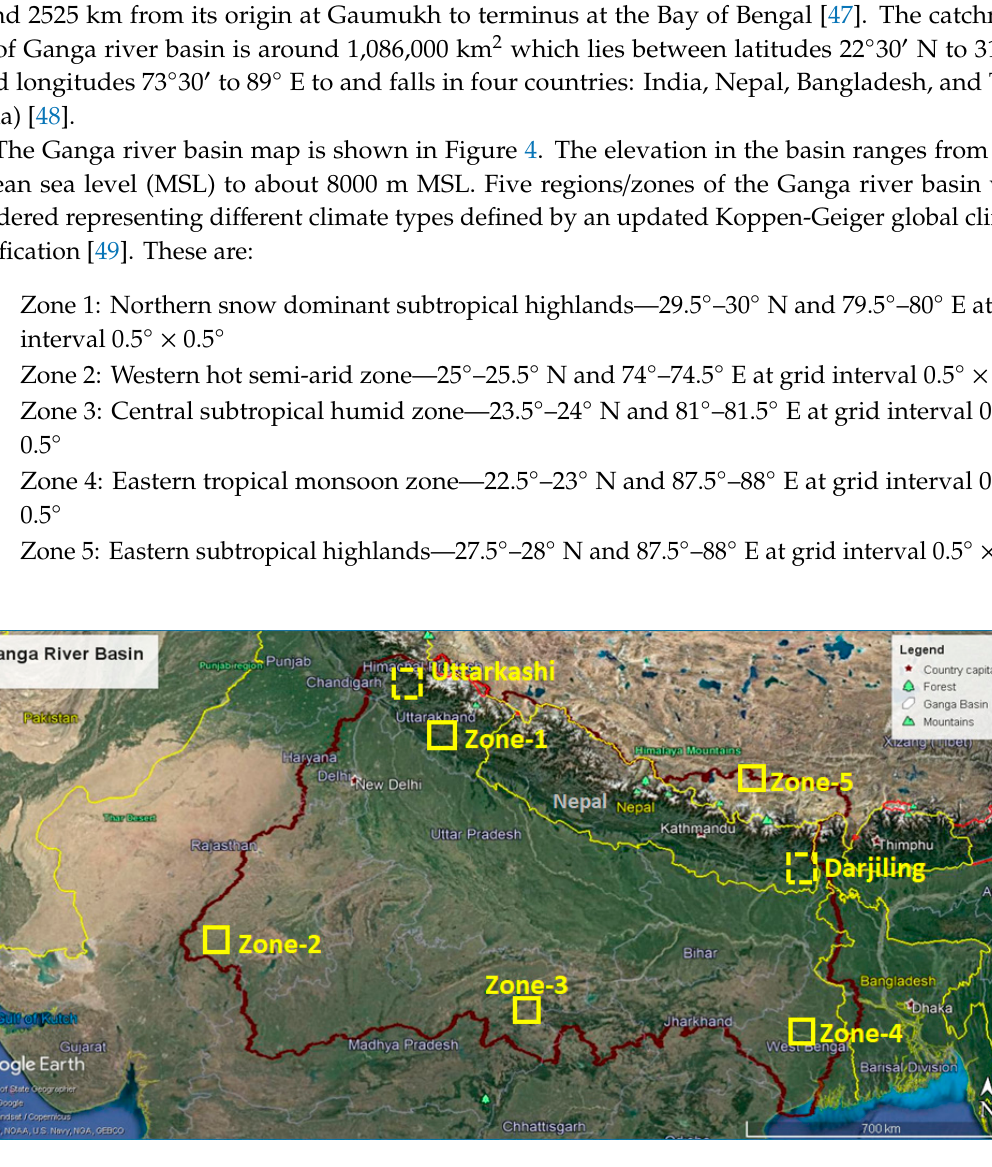
Figure 4. Study area in the Ganga river basin. Zones are shown by solid yellow rectangles and location of districts are shown by dashed yellow rectangles.